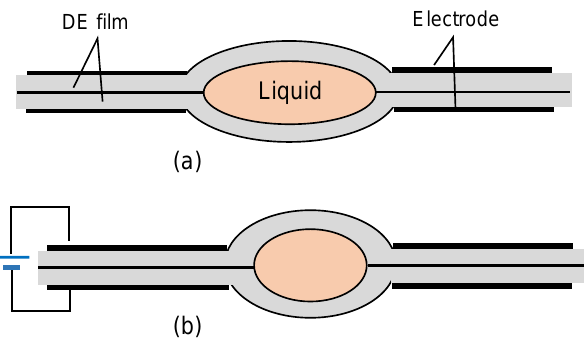
Figure 2. A liquid lens actuated using DEA films: ( a ) voltage-off state and ( b ) voltage-on state.